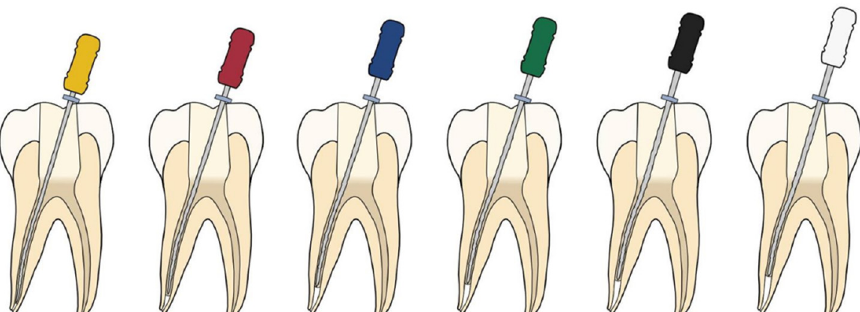
Figure 2. The Lawaty technique: hand files used to carry and pack MTA sequentially in a “step- back” method.